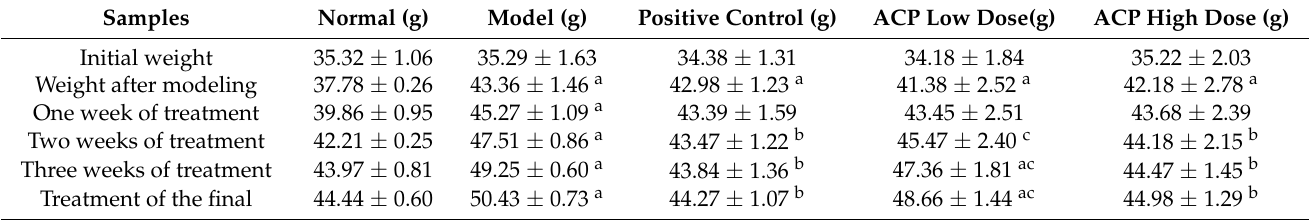
Table 1. Effects of ACP on weight in mice.